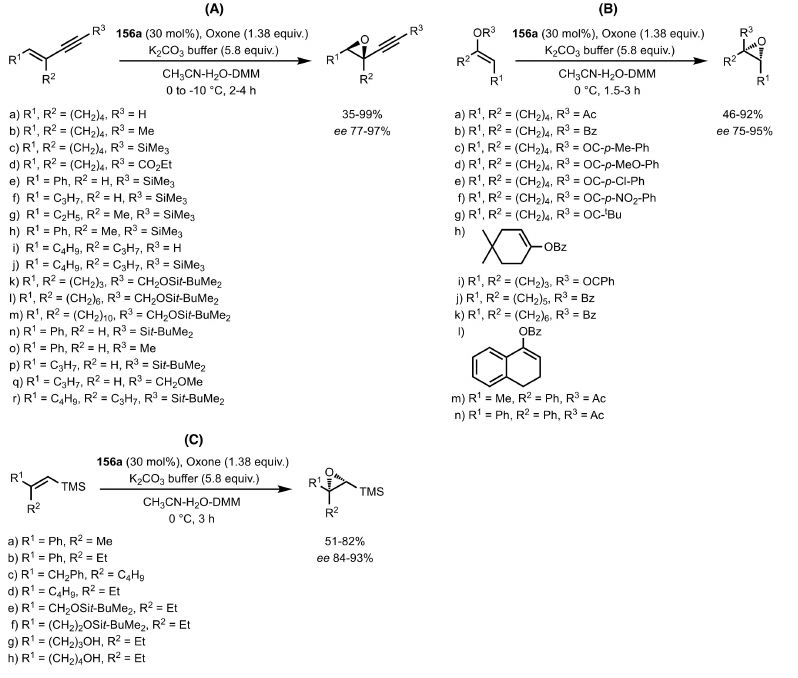
New organocatalysts for the epoxidation of trans -alkenes As sugar ketone 156a was found inefficient in the enantioselective epoxidation of terminal olefins as well as cis -alkenes, a large number of new organocatalysts were pre- pared by Shi and co-workers starting from D -fructose [85]. The compounds 156b-e were synthesised using various ketones and dimethoxyalkanes for the initial ketalization of the ketose, followed by standard oxidation (Scheme 39). A regioselective deprotection of 155a using 2,3-dichloro-5,6-dicyano- p -benzoquinone (DDQ) [86], followed by ketalization with different ketones and oxidation, yielded catalysts 156f-k